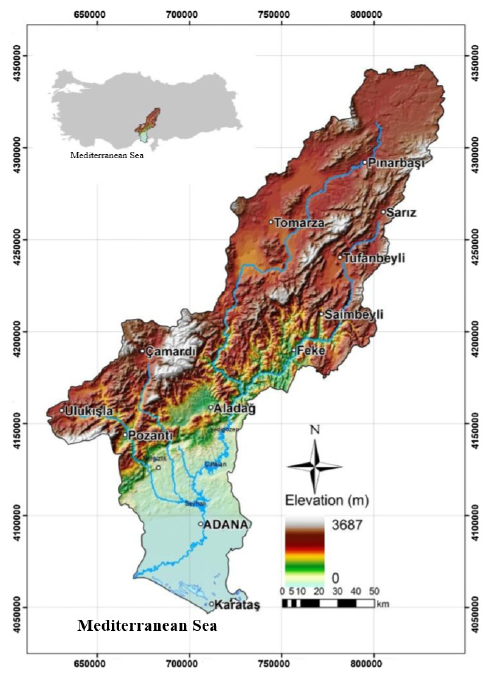
Figure 1. Topography of the Seyhan River basin.